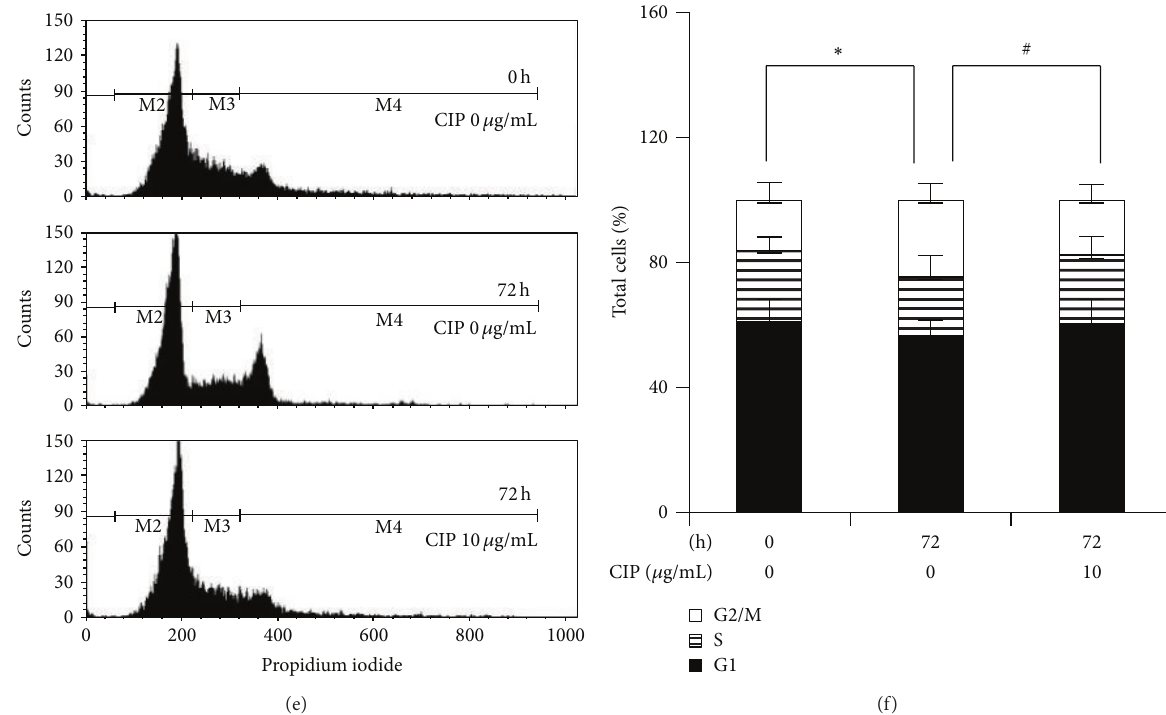
Figure 2: Effects of CIP on stem cell-like characteristics in DPCs. (a) Cells were treated with CIP (0–10 𝜇 g/mL) for various times (0–72 h). After indicated treatment, morphology of DPCs was observed. Scale bar is 100 𝜇 m. (b) Aggregation behavior of cells was determined after indicated treatment for 72 h. Scale bar is 100 𝜇 m. ((c)-(d)) Aggregation size and aggregation number were determined by image analyzer. The data represent the means of four independent samples ± SD. ∗ 𝑃 < 0.05 versus untreated control. ((e)-(f)) Cells were cultured in the presence or absence of CIP (10 𝜇 g/mL) for 72 h and serum-starved for 24 h. After serum-starvation, cells were incubated with complete media for 12h. The cells at the early passages (passages 2-3) without serum-starvation were also used as an untreated control at 0 h. Cell cycle distribution was determined by PI staining and flow cytometry. The data represent the means of four independent samples ± SD. ∗ 𝑃 < 0.05 versus untreated control at 0h; # 𝑃 < 0.05 versus untreated control at 72